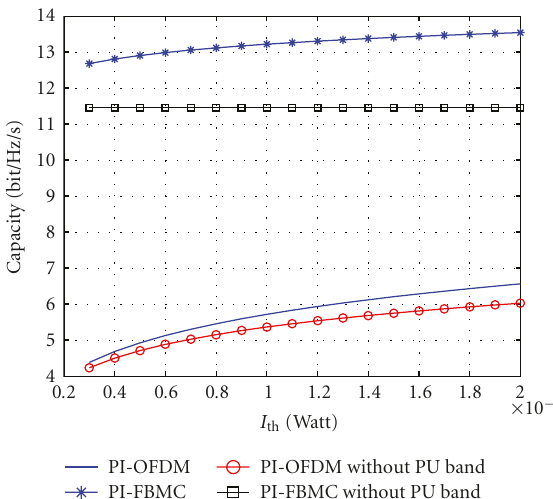
Figure 12: Achieved capacity versus allowed interference threshold (low) with and without transmitting over active bands—two active PU bands.